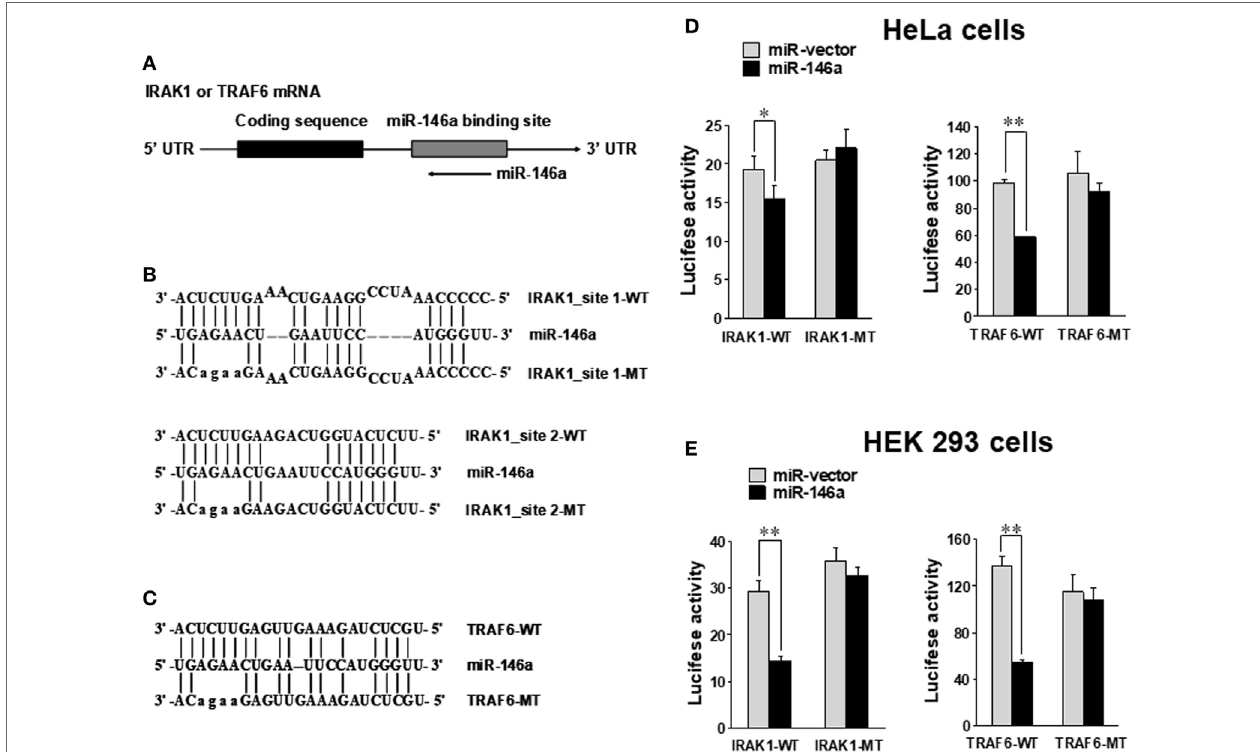
FigUre 5 | IRAK1 and TRAF6 are direct targets of miR-146a. Schematic representation of the IRAK1 and TRAF6 3 ′ UTR indicating the putative binding sites of miR-146a (a) . Sequence alignment of miR-146a and its target sites in 3 ′ UTRs of TRAF6 (B) and IRAK1 (c) . WT and MT indicate wild-type and mutant sequences, respectively. In the IRAK1-UTR-MT plasmid, both miR-146-binding sites were mutated as shown. HeLa cells (D) and 293T cells (e) were transiently co-transfected with either pGL3 luciferase vector containing a fragment of IRAK1 and TRAF6 3 ′ UTR harboring miR-146a binding sites or the corresponding mutant constructs. Luciferase activities were normalized to the activity of renilla luciferase. Data shown are representative of at least three experiments with similar results and are presented as mean ± SD. * p < 0.05; ** p < 0.01. Error bars represent